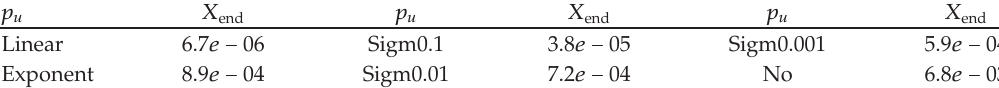
Table 1: Standardized value of di ff erent mutation factors.